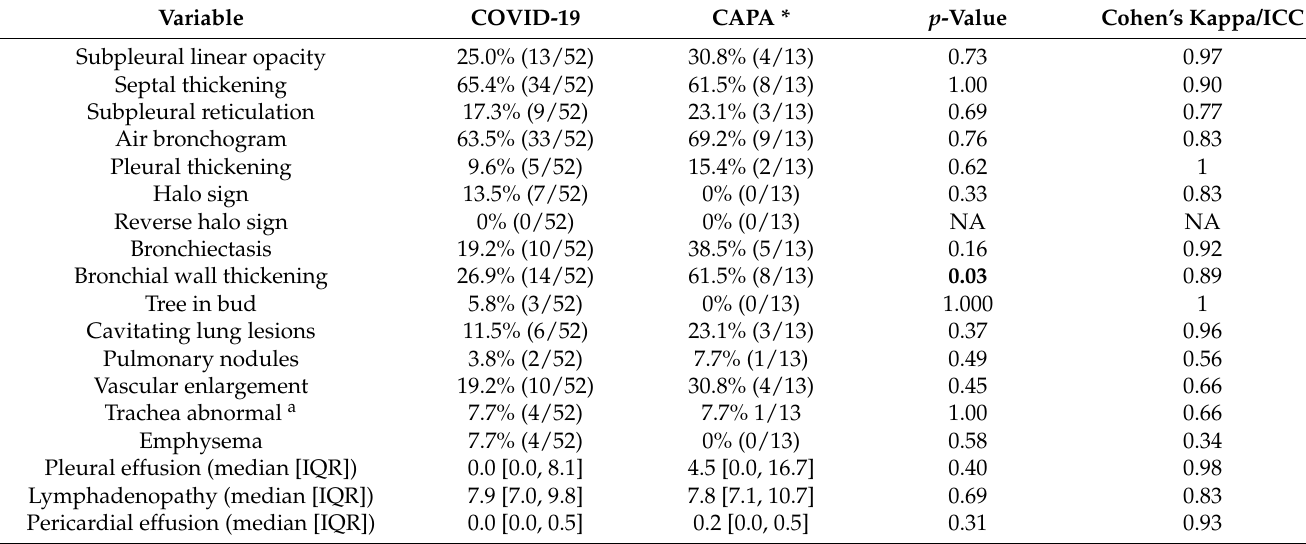
Table 2. Comparison of additional findings between patients with COVID-19 and with CAPA.